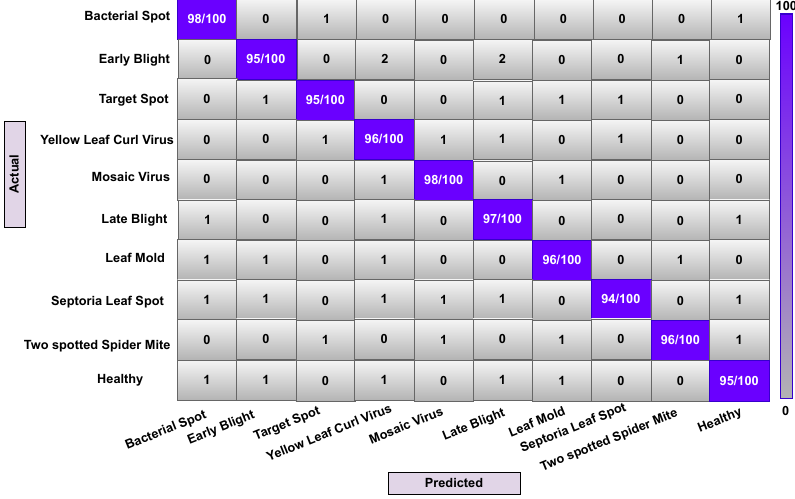
Figure 14. Confusion matrix of LR method during